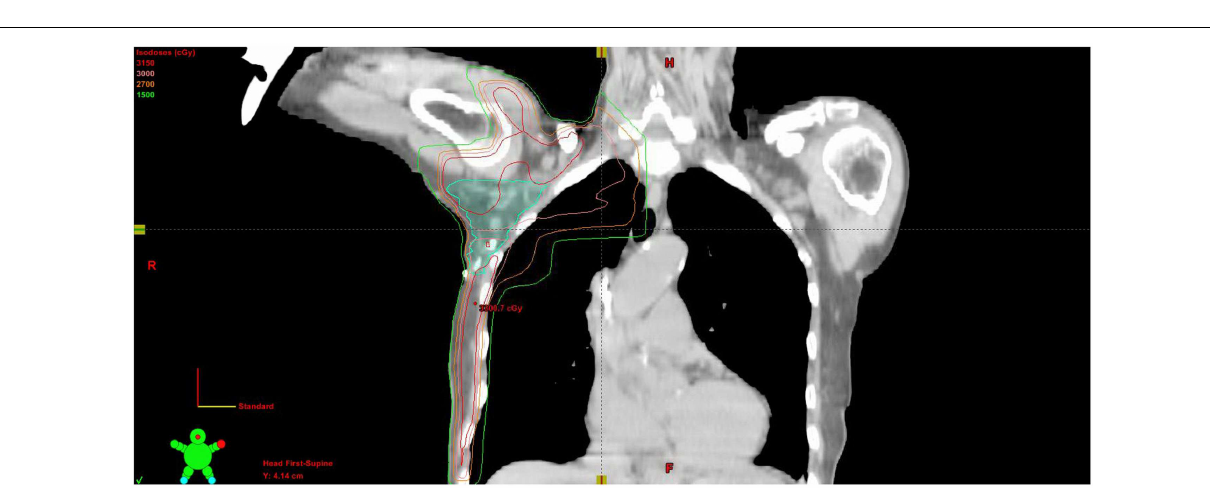
FIGURE 4 | Right axillary lymphadenopathy demonstrated on axial and coronal PET scan images with abnormal FDG avidity (A,B) and coronal CT images with contrast (C,D) .